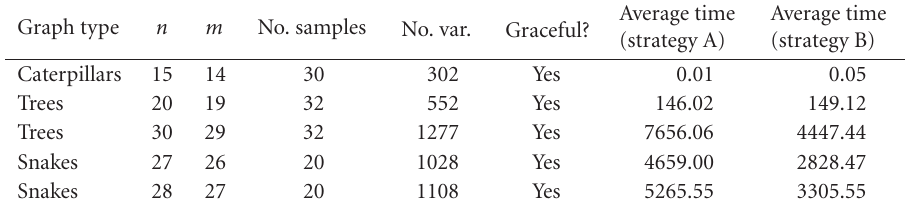
Table 4.1. Comparison of two methods for branching rule in branching method.